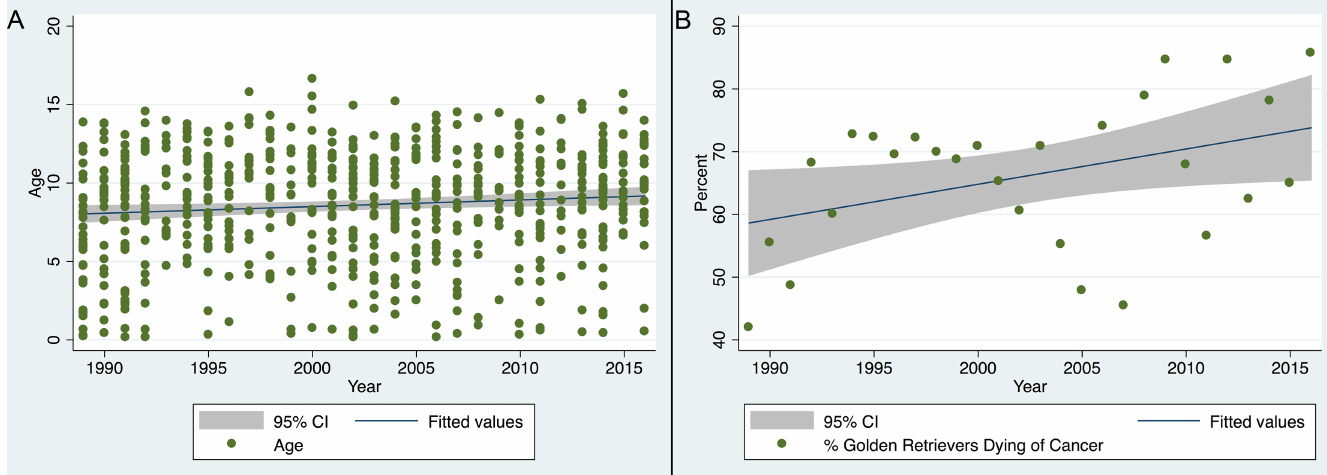
Fig 3. Percent of golden retriever dogs dying of cancer and age of death over time. (A) Scatter plot with fitted regression line and 95% CI showing percent of golden retriever dogs undergoing necropsy exam that died from cancer by year. The results show a significant (P = 0.38, R 2 = 0.16) but weak increase in the proportion of dogs with a cancer diagnosis over time. (B) Scatter plot with fitted regression line and 95% CI showing age of golden retriever dogs presenting for necropsy over time. The results show a significant but week increase in age over time (P = 0.01, R2 = 0.009).